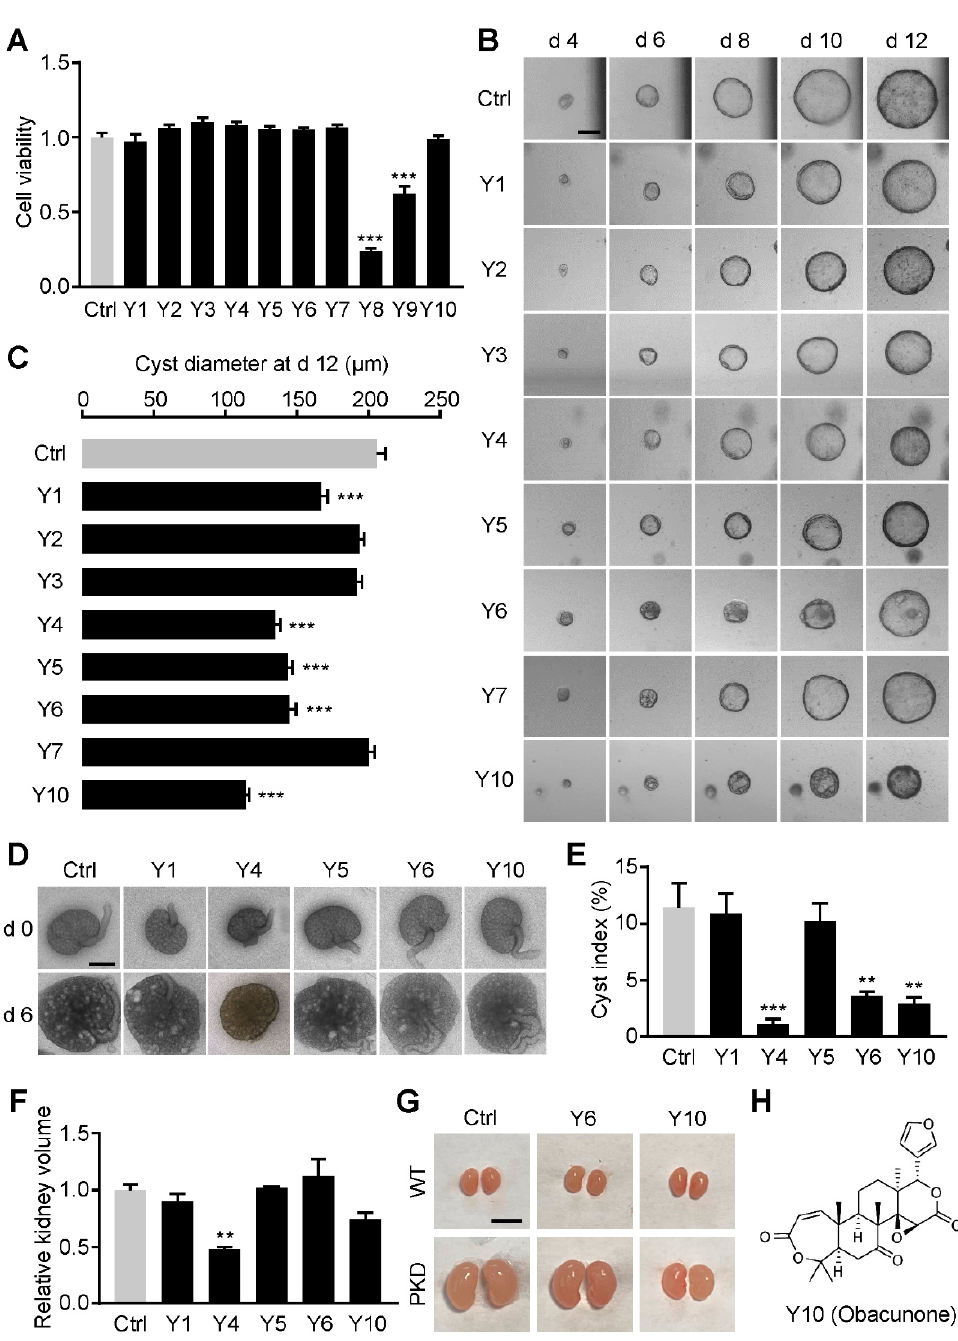
Figure 1. Identification of obacunone as a potent renal cyst inhibitor. ( A ) Cytotoxicity of 12.5 µ M candidate compounds on MDCK cells. n = 5. ( B ) Representative images of MDCK cysts treated without (Ctrl) or with 12.5 μ M candidate compounds. Bar = 100 μ m. ( C ) Diameters of MDCK cysts at day 12. n = 30. ( D ) Representative images of embryonic kidneys. Bar = 500 μ m. ( E ) Cyst indices of embryonic kidneys at day 6. n = 6. ( F ) Volumes of embryonic kidneys at day 6. n = 6. ( G ) Representative images of kidneys from wild-type (WT) or kidney specific Pkd1 knockout mice (PKD) treated without or with 100 mg/(kg·d) candidate compounds. Bar = 0.5 cm. ( H ) Chemical structure of Y10. Data are presented as means ± SEM. ** p < 0.01, *** p < 0.001, versus Ctrl. CCK-8 assay showed that obacunone had no significant cytotoxicity to MDCK cells at concentration of 50 μ M and below (Figure 2A). We first evaluated the effect of